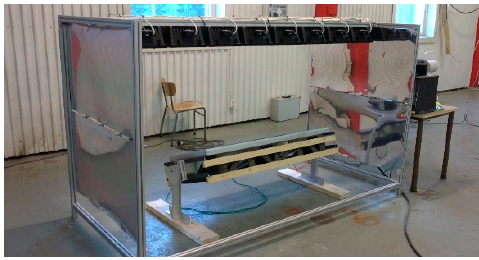
Figure 4. The solar simulator for the indoor measurements.